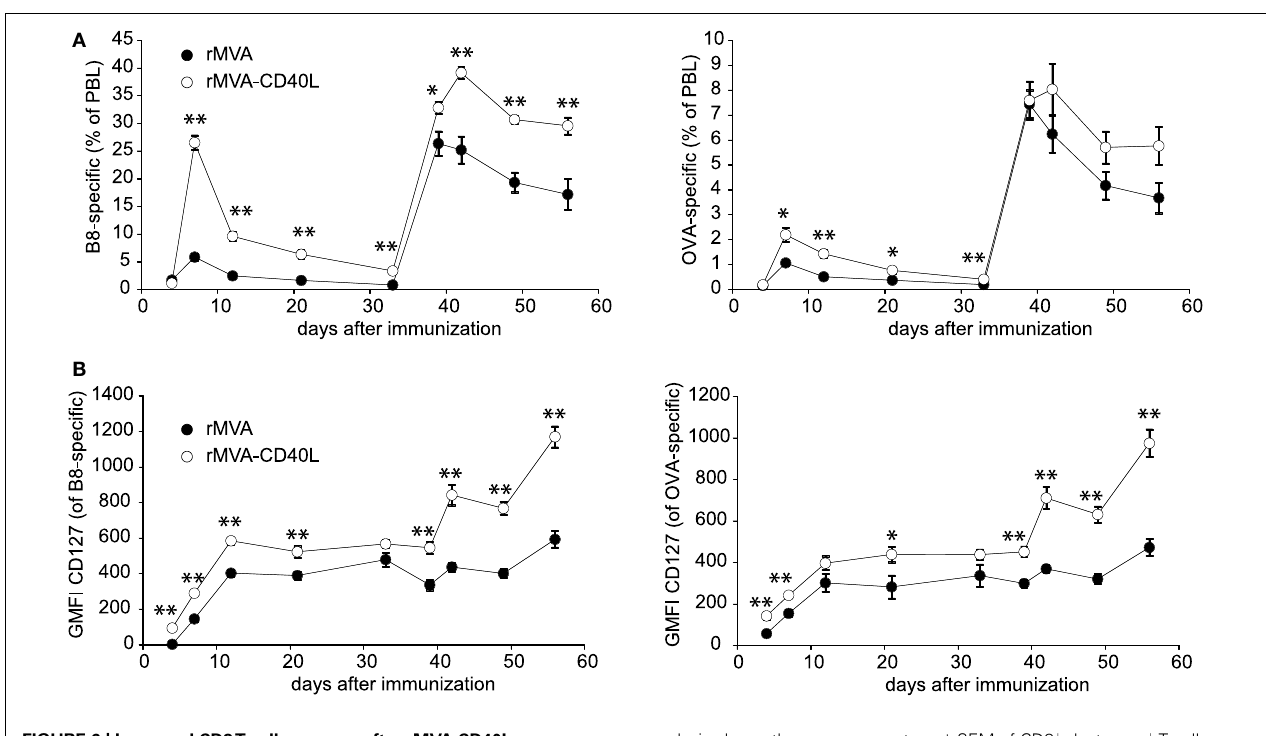
FIGURE 6 | Increased CD8T cell response after rMVA-CD40L immunization . C57BL/6 mice were immunized with rMVA and rMVA-CD40L on day 0 and 35.The primary and secondary B8- and OVA-specific CD8T cell response was quantified by dextramer staining of PBL at the indicated time points as shown in Figure 1A . (A) The kinetic